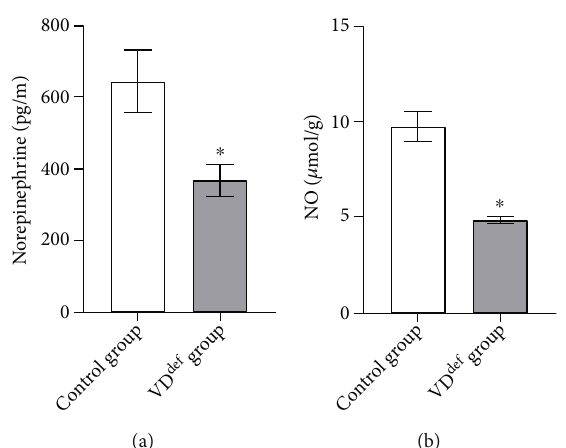
Figure 4: E ff ects of VD def on local plasma hormones in the cardiac. (a) Determination of NE concentration by HPLC. (b) The concentration of NO was determined by NO kit. ∗ P < 0 : 05 vs. the control group.